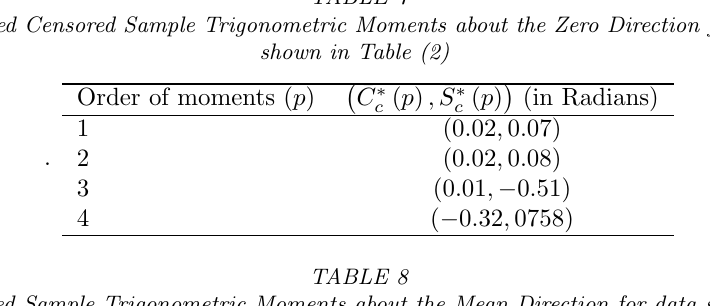
Censored Sample Trigonometric Moments about the Mean Direction for data shown